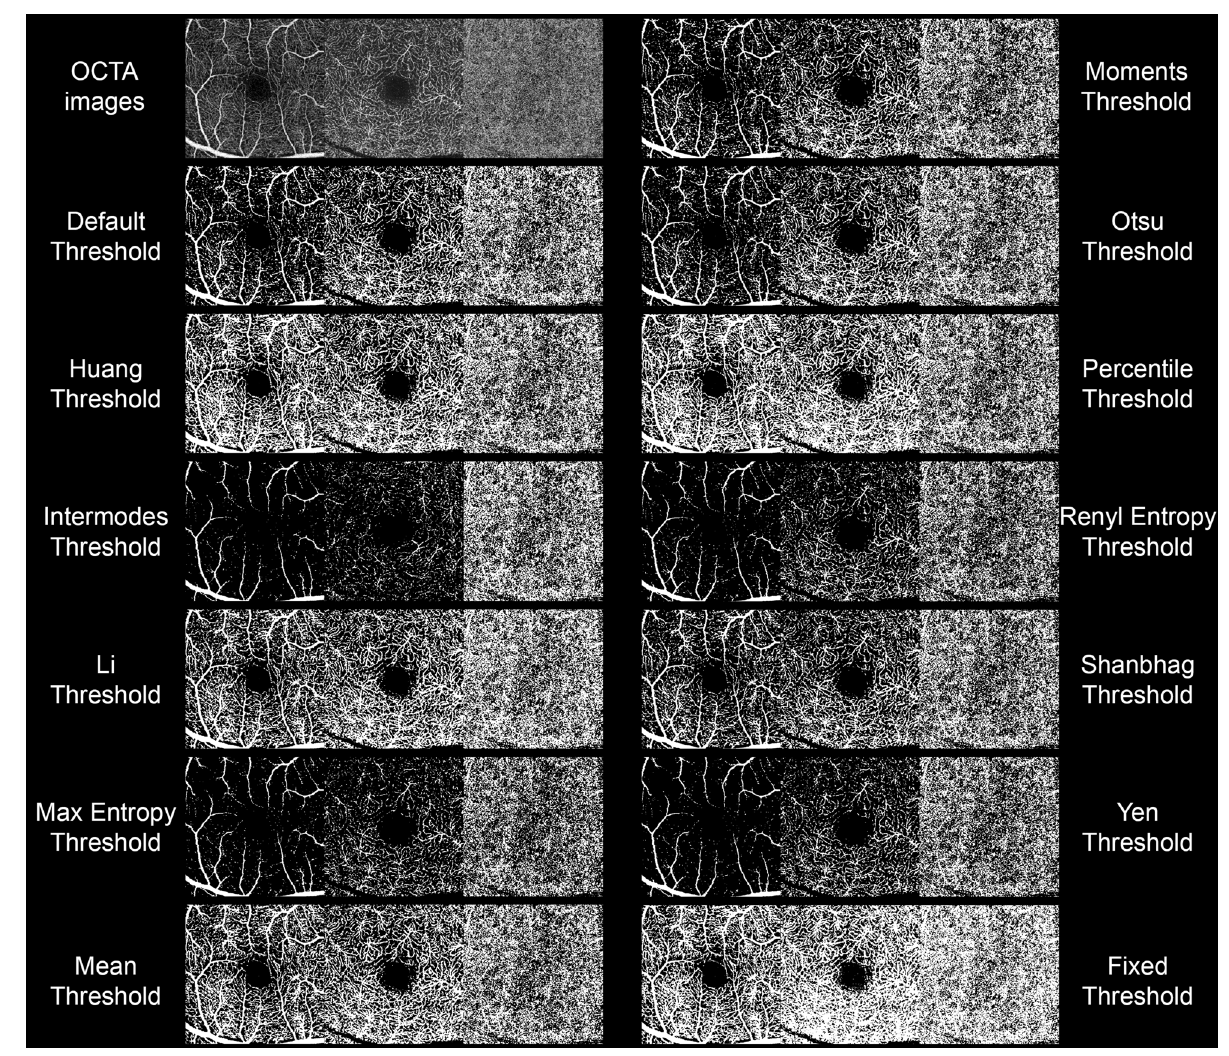
Figure 2. Binarized OCTA reconstructions obtained through all the included binarization techniques. Quality